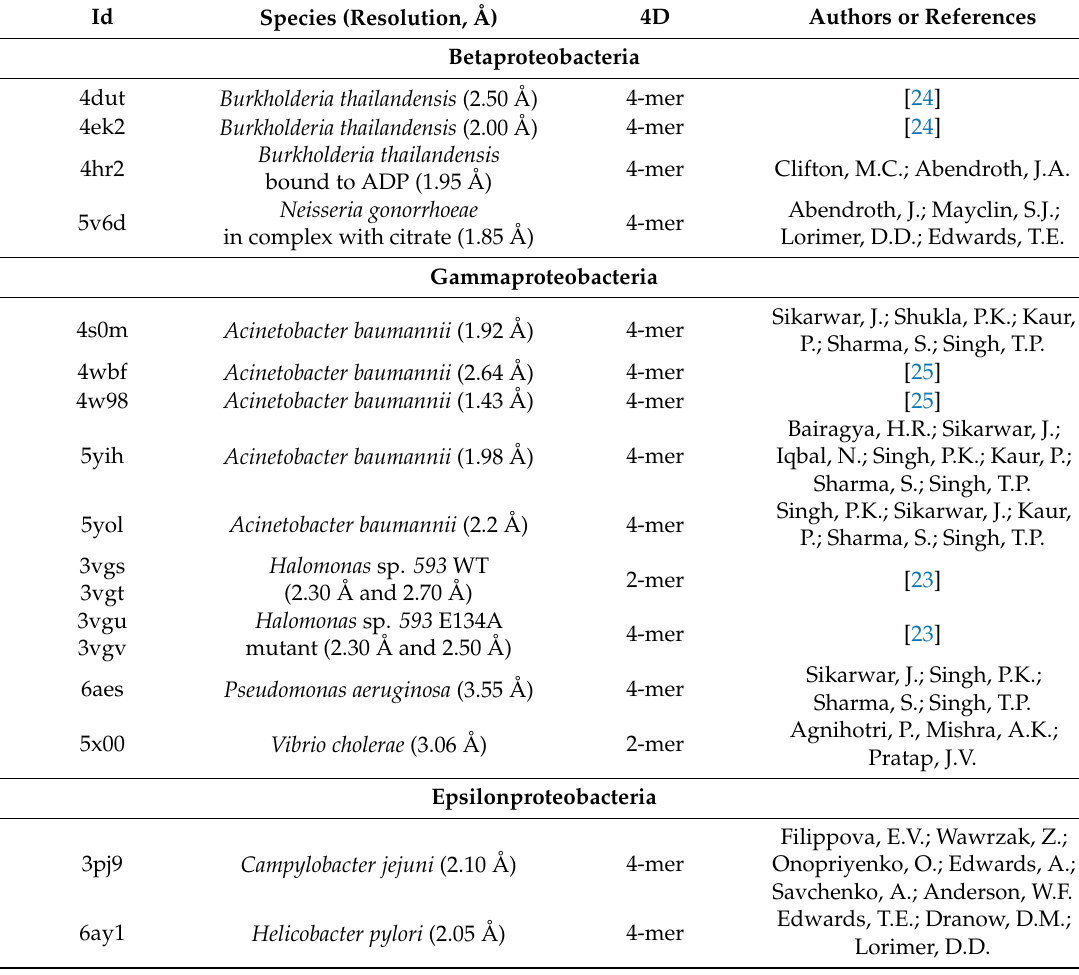
Table 1. Dimer and tetramer NDPK structures recently deposited in the Protein Data